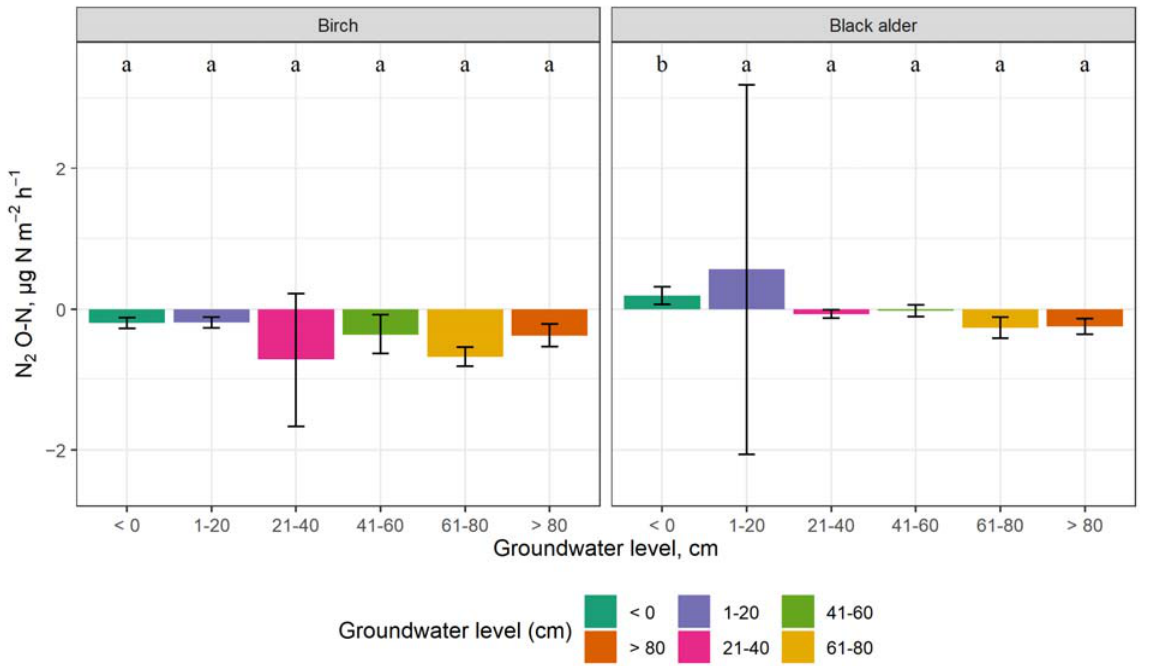
Figure 11. N 2 O fluxes and removals depending on the groundwater level in silver birch and black alder stands. Different lowercase letters show statistically significant differences ( p < 0.05, two-ample t -test) between tree species within the same groundwater level group.